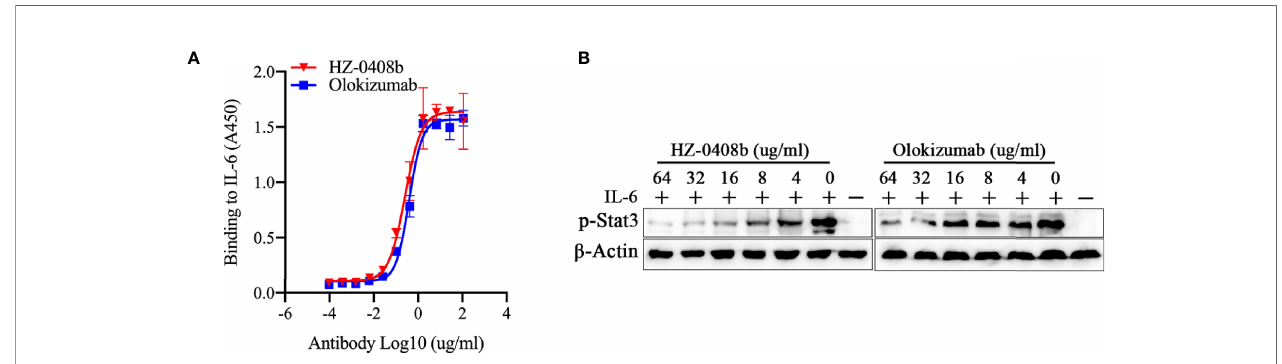
FIGURE 3 | HZ-0408b is comparable to Olokizumab in blocking IL-6 signaling. (A) The binding activity of the HZ-0408b and Olokizumab to IL-6 was measured by ELISA using an HRP-conjugated anti-human IgG secondary antibody. Each sample was assayed in triplicates. Mean absorbance at 450nm and SD values are presented. (B) HZ-0408b and Olokizumab inhibited STAT3 signaling activity. DLD-1 cells were cultured in the presence of 10ng/ml IL-6 and indicated concentrations of HZ-0408b and Olokizumab were added for 2 hr. STAT3 phosphorylation at T705 was measured by western blot.